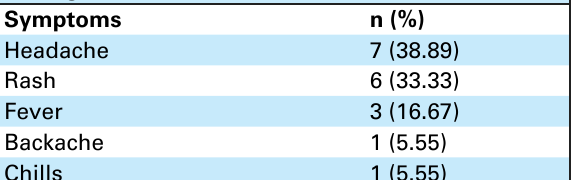
Figure 2. Epidemiological curve of the outbreak. Among the cases, the most common first symptom seen was headache in 7 (38.89%) cases (Table 1). Table 1. First symptom of chickenpox observed among cases (n= 18).